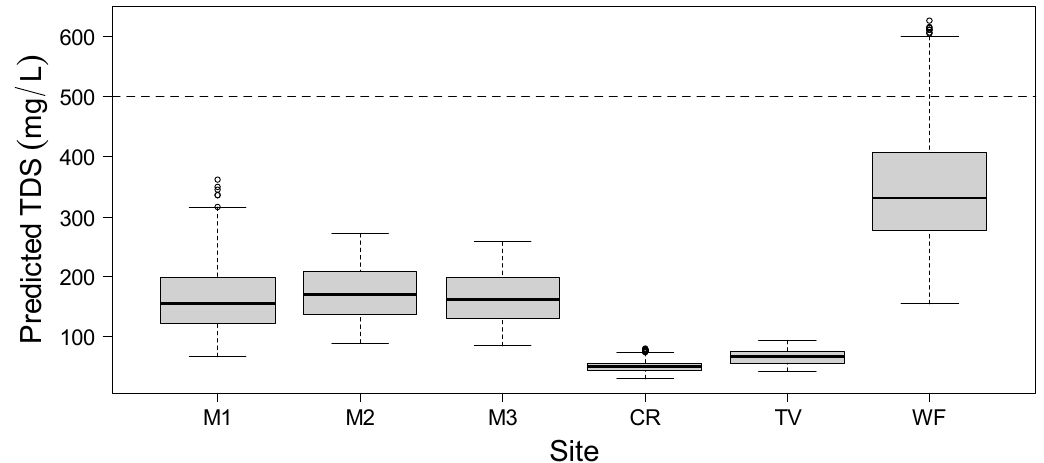
Figure 2. Variability in predicted total dissolved solids (TDS) concentrations across all days and years within and among the six sites on the Cheat (CR), Tygart Valley (TV), West Fork (WF), and Monongahela (M) Rivers. Refer to Figure 1 for site locations.